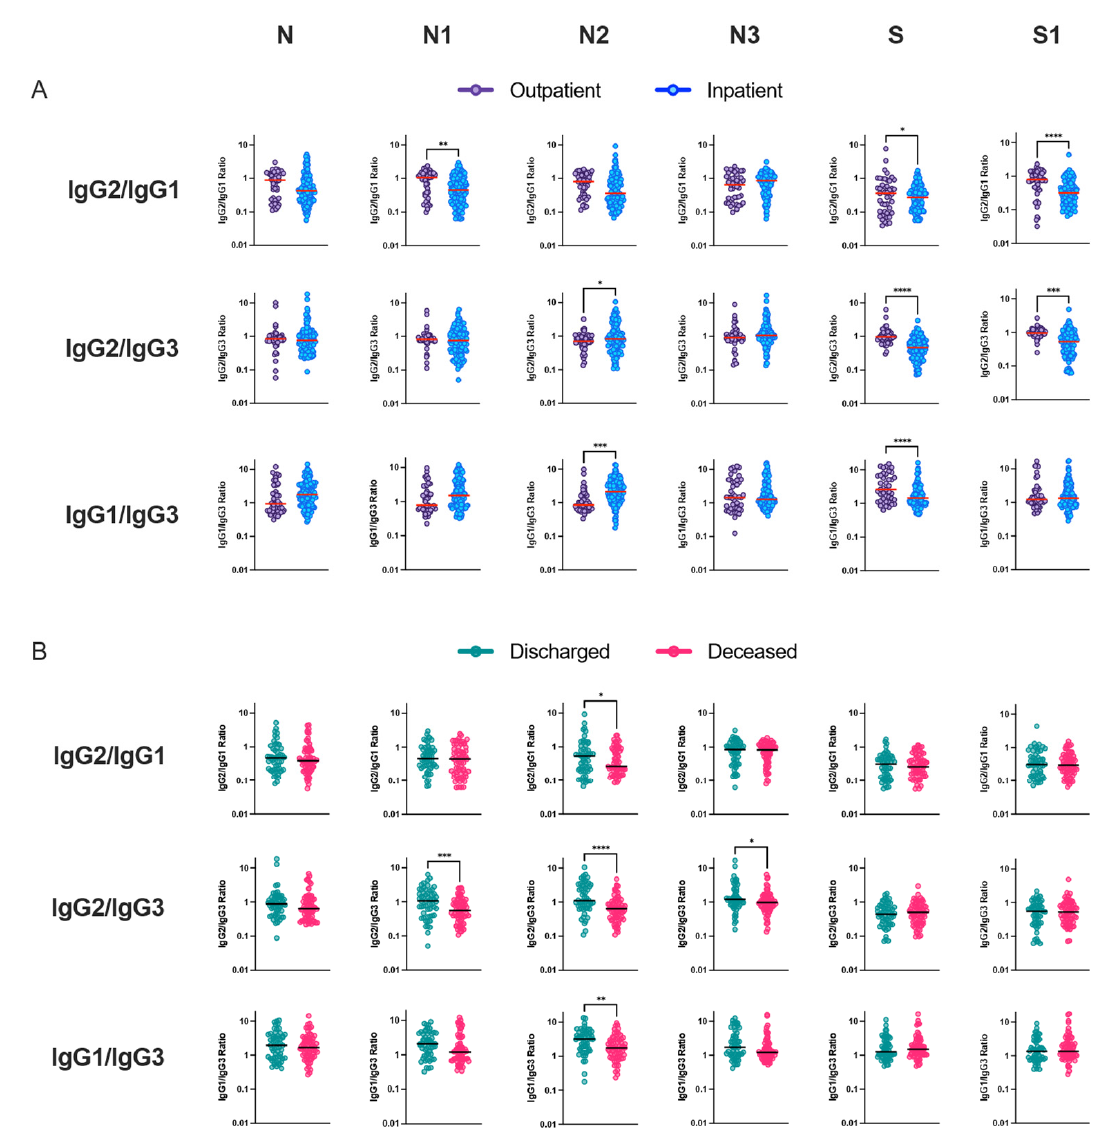
Figure 4. Elevated antigen-specific IgG3 response correlated with severe disease outcome. IgG sub- class antibody ratio correlates with disease outcome. Ratio of full-length and truncated N and S protein-specific IgG subclass antibody response was compared between ( A ) outpatients (n = 45) and inpatients (n = 38, samples n = 121) or ( B ) hospitalized patients with discharged (n = 20, samples n = 55) or deceased (n = 18, samples n = 66) disease outcome. Samples with more than seven days after the start of symptoms were included in this analysis. T-test was performed to compare patient groups. * p < 0.05, ** p < 0.01, *** p < 0.001, **** p <